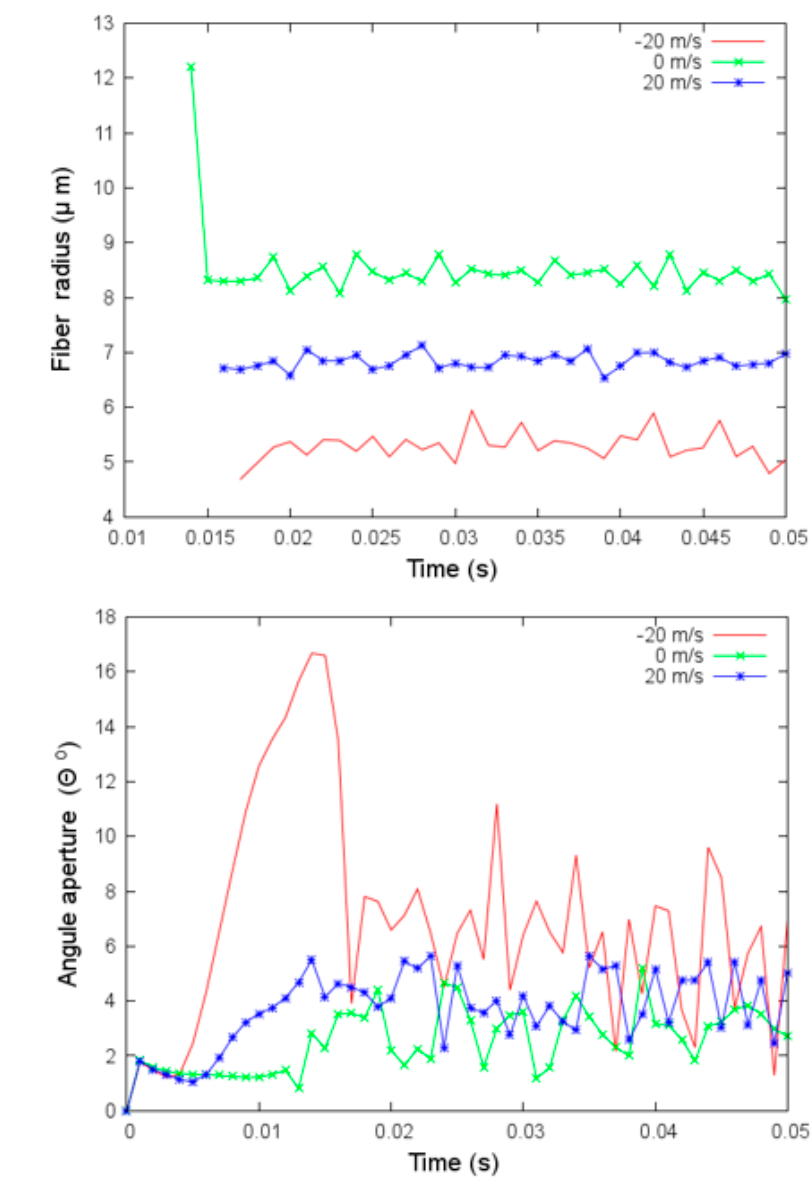
Figure 7. ( a ) Angular aperture versus time and ( b ) fiber radius versus time for different values of the velocity of the flow, v f under parameters given in Table